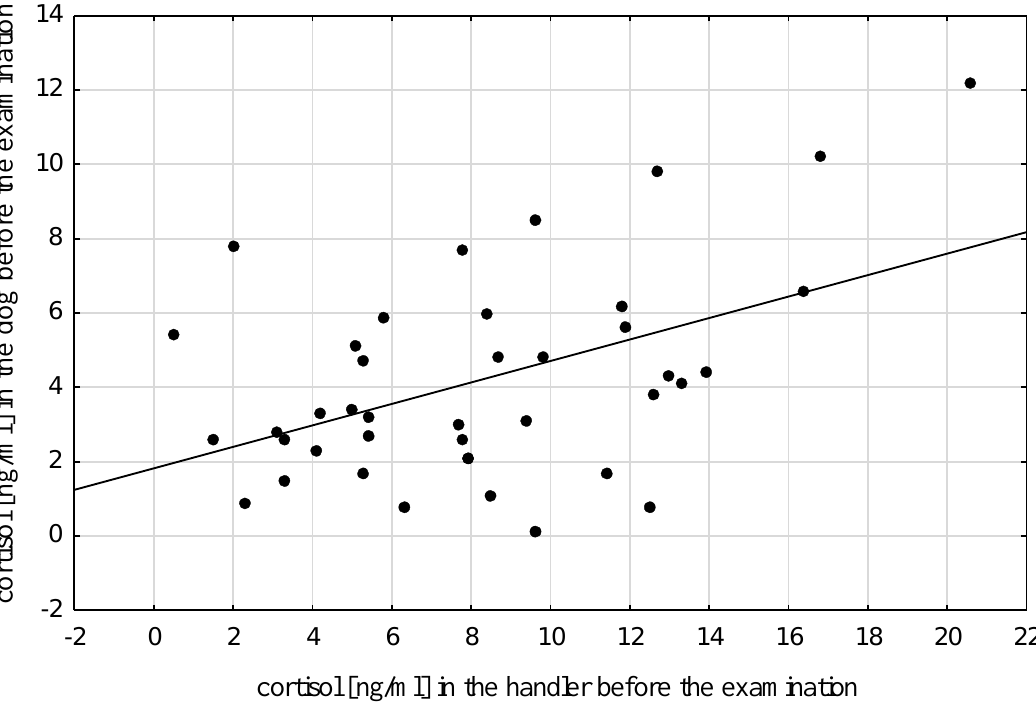
Figure 3. Scatter plot for the correlation between cortisol levels in the dogs and their handlers before the examination.